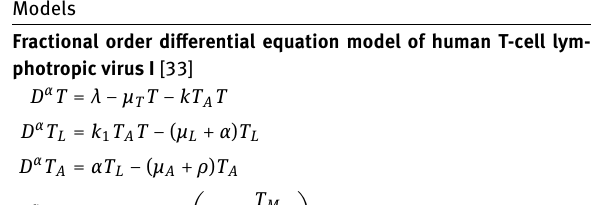
Table 1. Biomathematics and epidemic models that have been in-